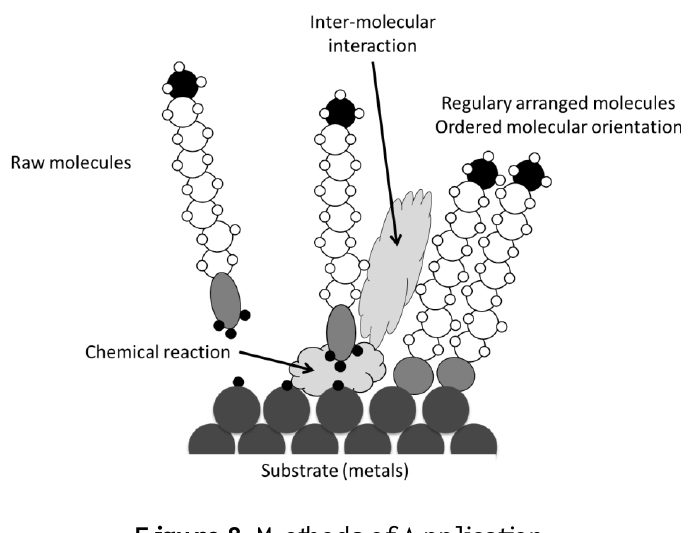
Figure 8. Methods of